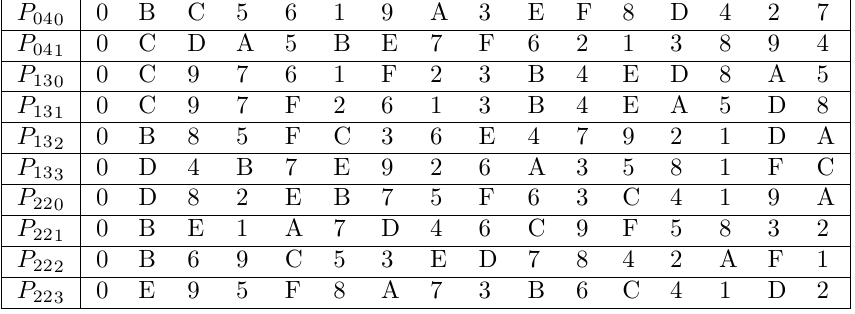
Table 14: Representatives for all 10 classes of Platinum S-boxes [ZBRL15]. In the form P ij , the index i represents CardD1 = i , the index j represents CardL1 = j , and index k k represents the index of one PXE-class within one P ij